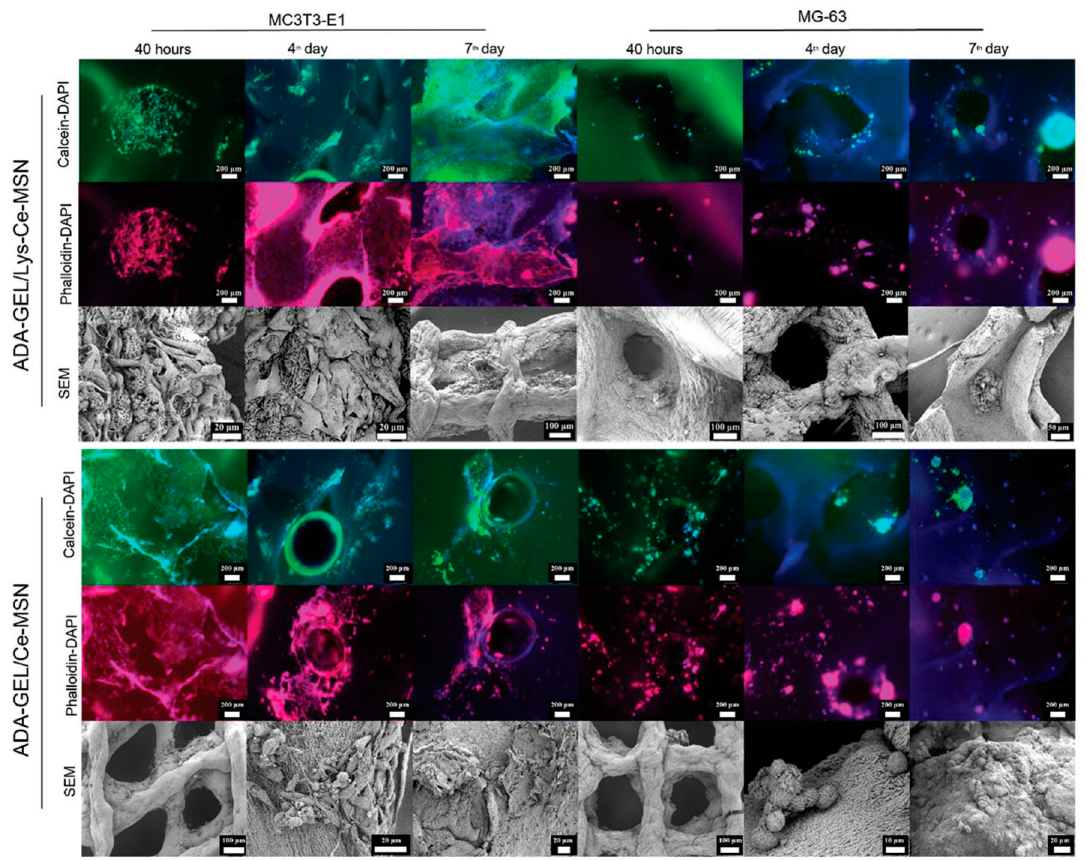
Figure 9. Morphology of MC3T3-E1 and MG63 cells adhered on scaffolds imaged by fluorescence microscopy (after Calcein/DAPI and Phalloidin/DAPI staining) and SEM after 40 h, 4 days, and 7 days of incubation [56].